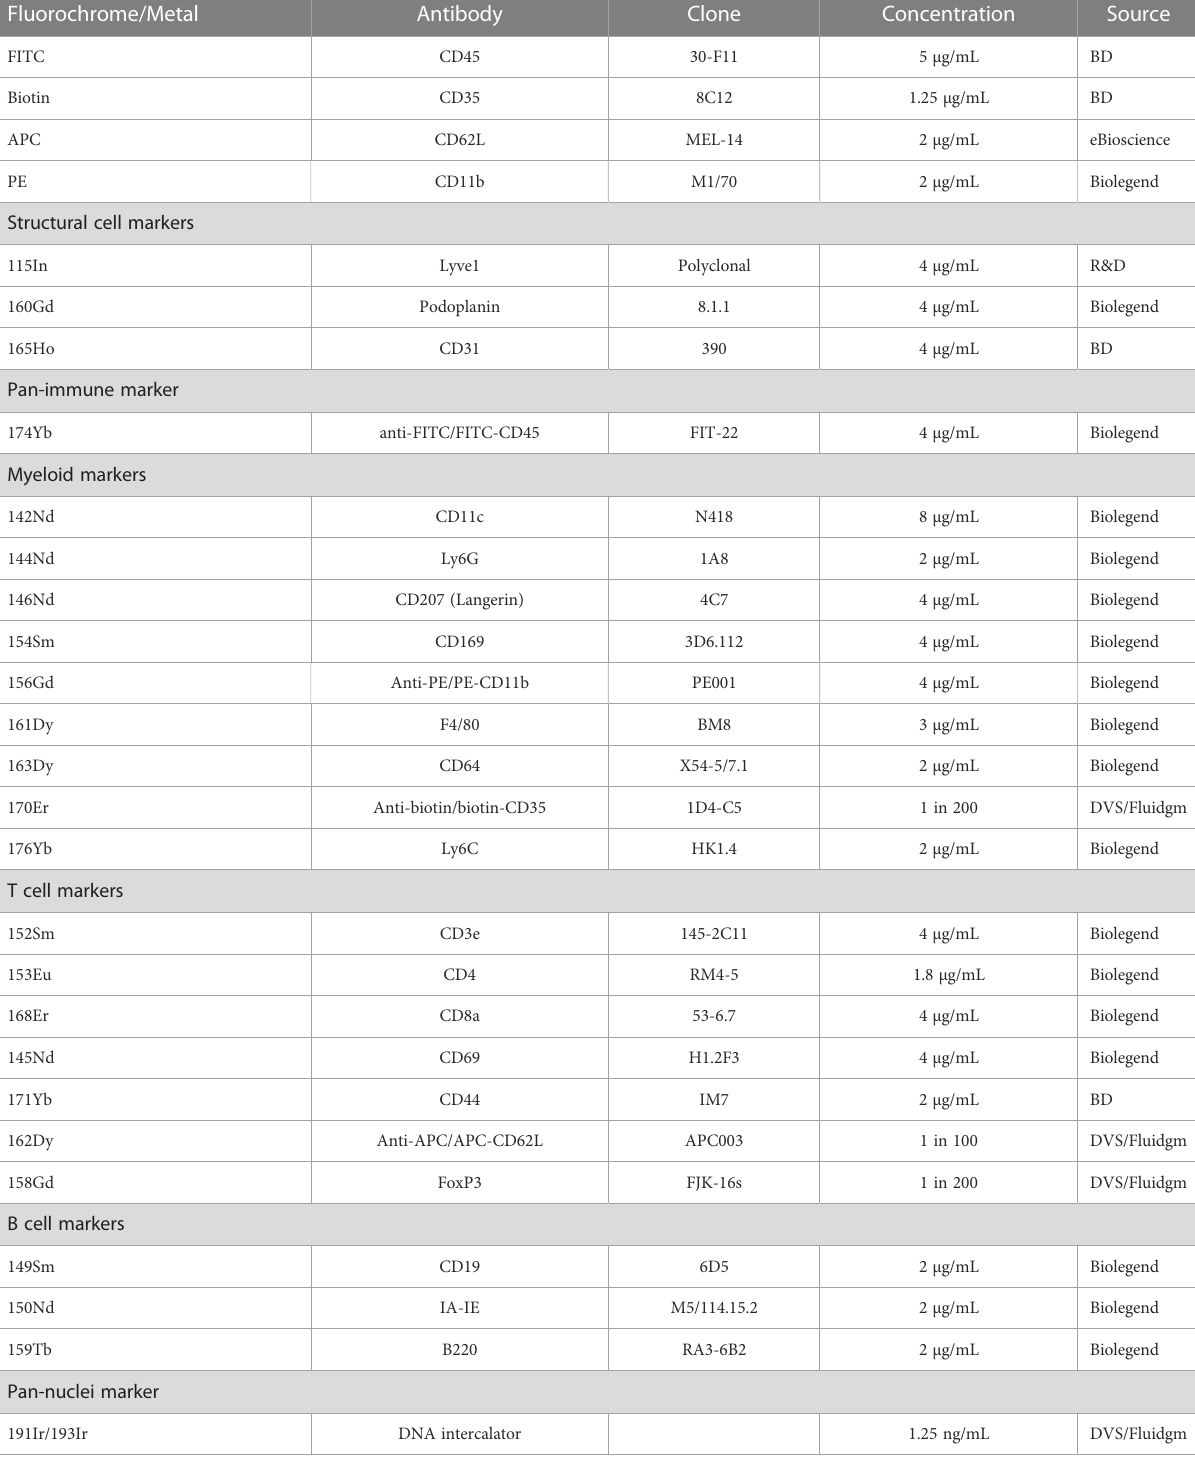
TABLE 1 List of antibodies used for imaging mass